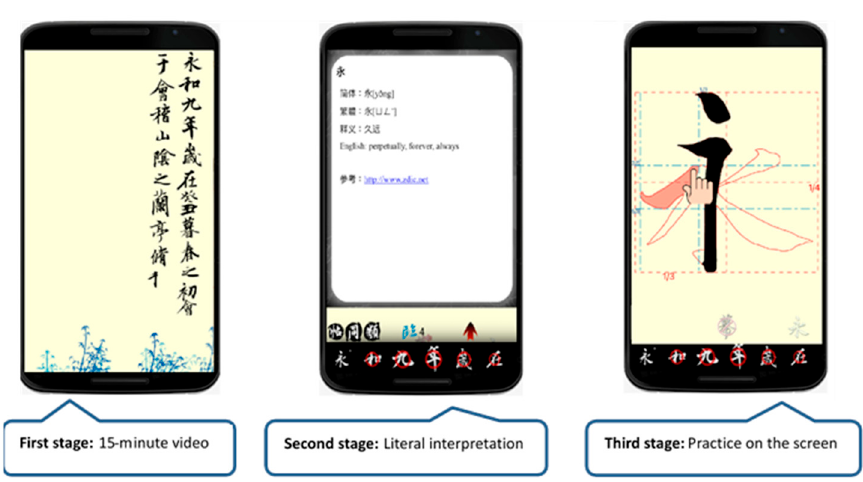
Figure 4. Schematics showing the operation of the calligraphy E-book.